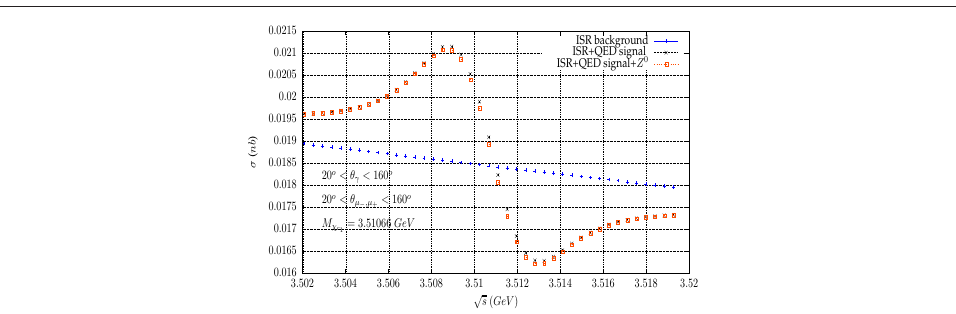
Figure 1. The cross section of e + e (cid:0) ! (cid:13)(cid:22) + (cid:22) (cid:0) with interference between the signal process and the continuum background process taken into account, predicted by Ref.